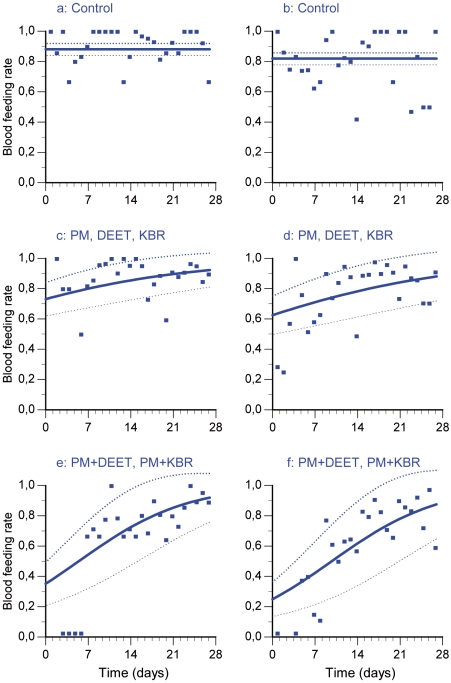
Blood feeding rates over time in the minimal adequate logistic regression model standard error bounds.a, c and e illustrate the trial during dry season 2006; b, d and f illustrate the trial during rainy season 2006.